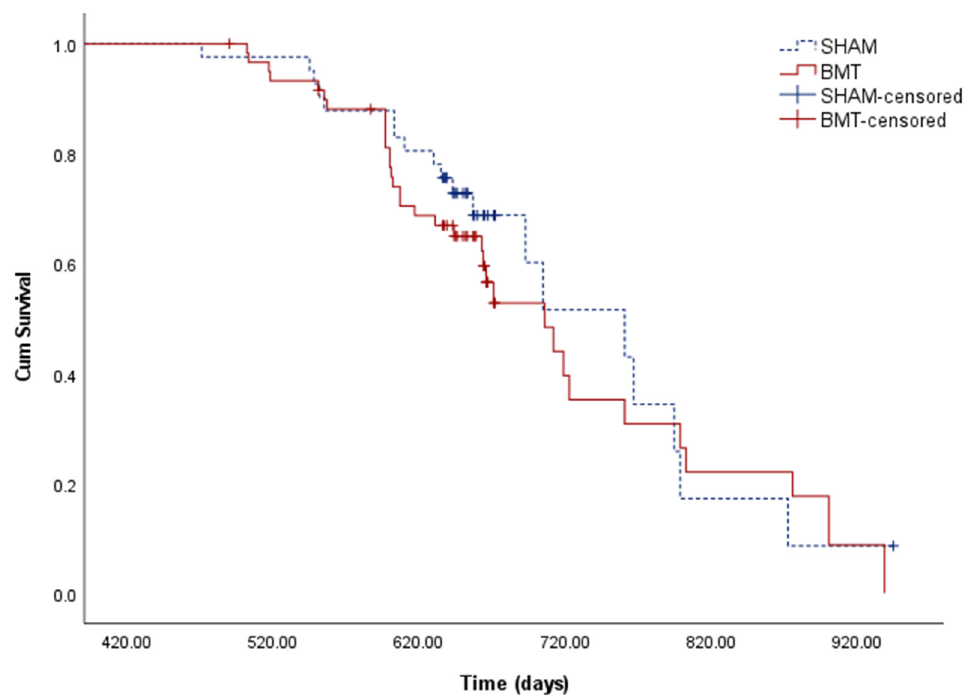
Figure 5. Kaplan–Meier survival curves. The equality test showed no significant differences between the transplanted group (BMT) and the control group (SHAM). BMT-censored and SHAM-censored are the mice that died during the transplantation process or were deliberately euthanized for the immune system analyses.